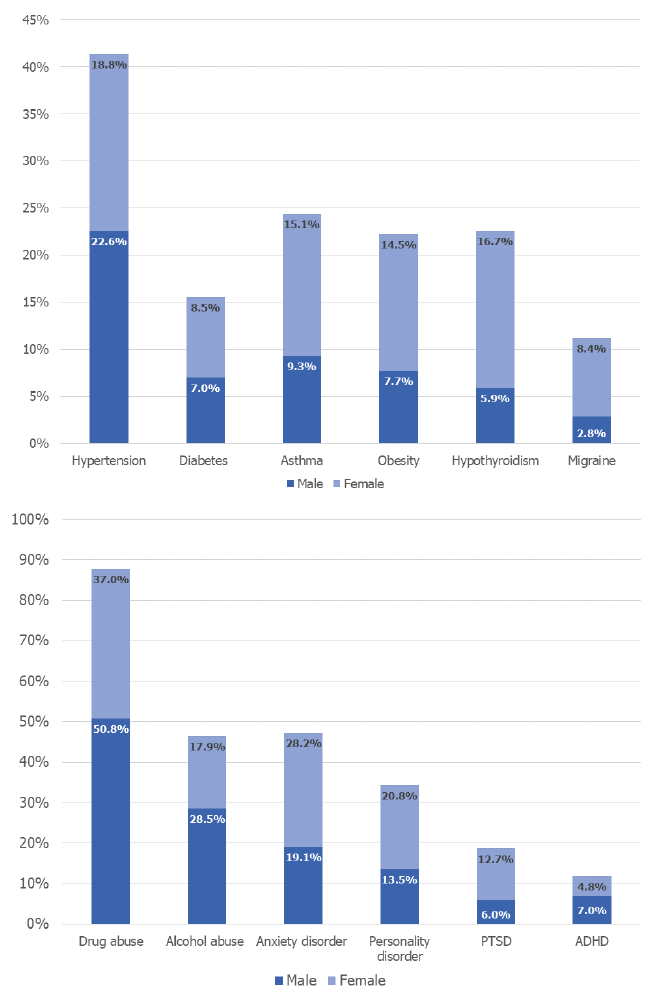
Figure 1. Gender-wise distribution of comorbidities in patients with bipolar disorder. The proportion of males and females with bipolar disorder were obtained using cross tabulation and the Pearson Chi-Square ( χ 2 ) test, and were significant with p value ≤ 0.01 at a 95% confidence interval. PTSD: Post-traumatic stress disorder; ADHD: Attention-deficit/hyperactivity